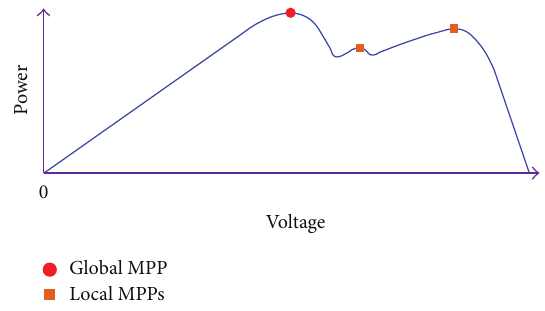
Figure 8: An illustrative P - V curve for PV systems under partial shading.